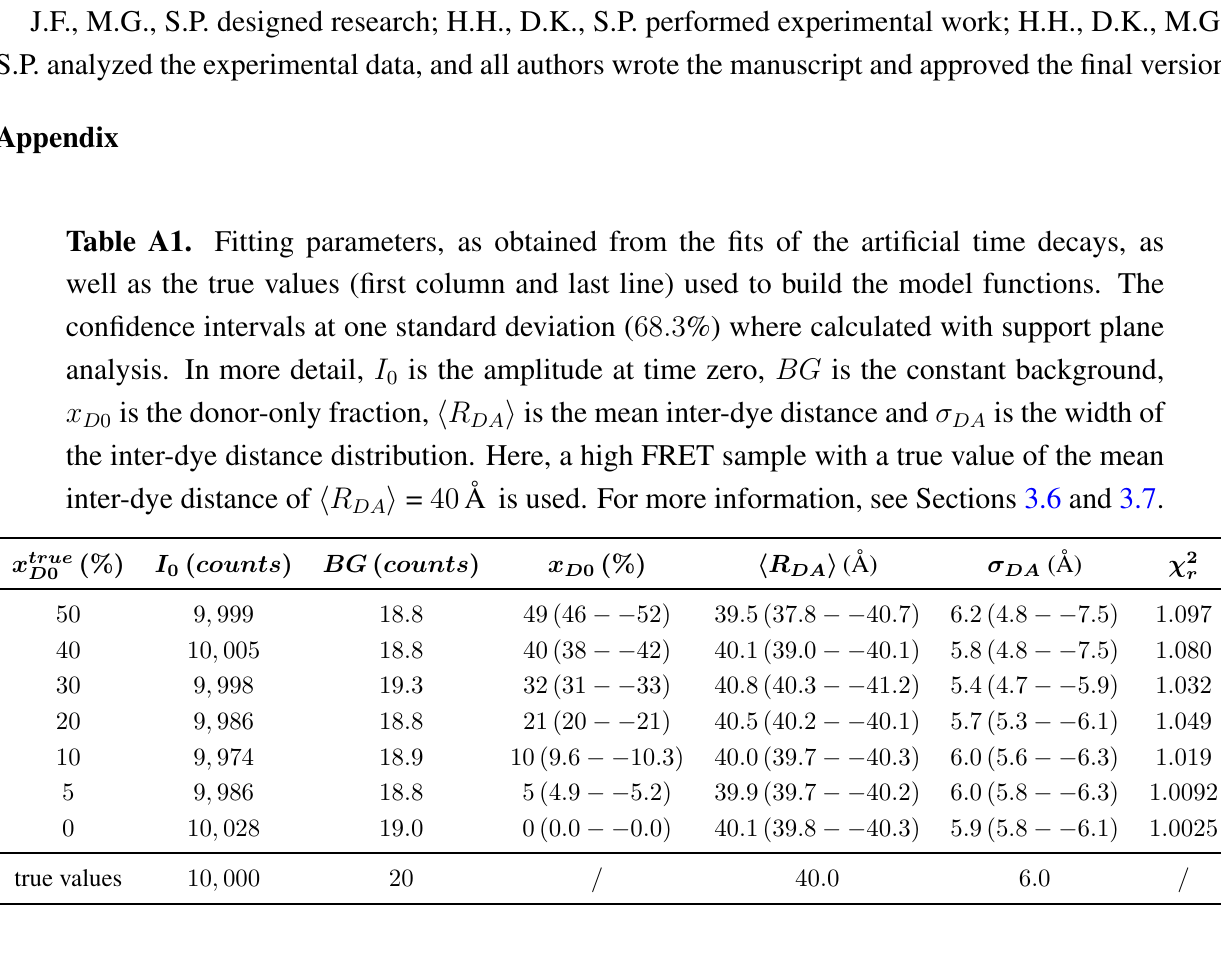
is the width of DA